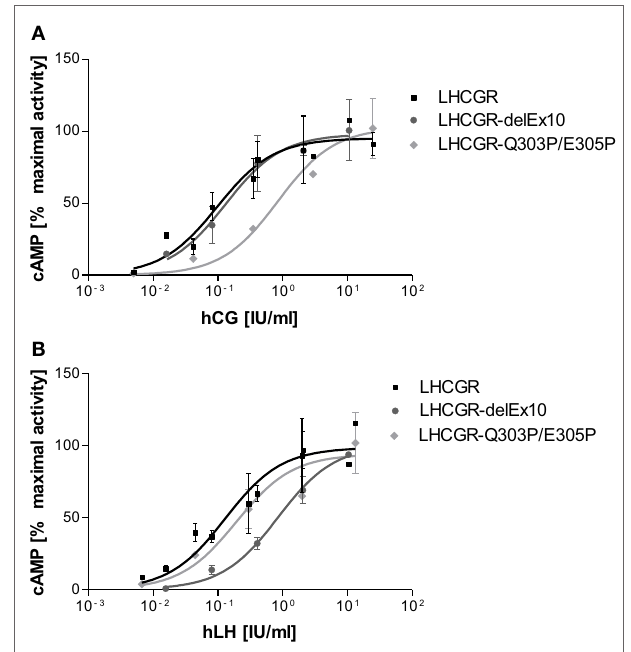
FigUre 6 | concentration-response curves differ for lh and hcg at lhcgr-wt and lhcgr-delexon10 . It is shown that the mean of experimental values of two independent runs normalized on maximal activity. (a) Stimulation with hCG shows for the LHCGR-delExon10 construct (dark) LHCGR-wild-type (black) like properties; the helix-disturbing double proline LHCGR mutant Q303P/E305P substituted into exon10 (light) shows a right-shifted concentration-response curve. (B) By contrast, stimulation with hLH, shows a substantial right shift for the LHCGR-delExon10 construct (dark), whilst the function of the double proline LHCGR mutant Q303P/ E305P is nearly unaffected